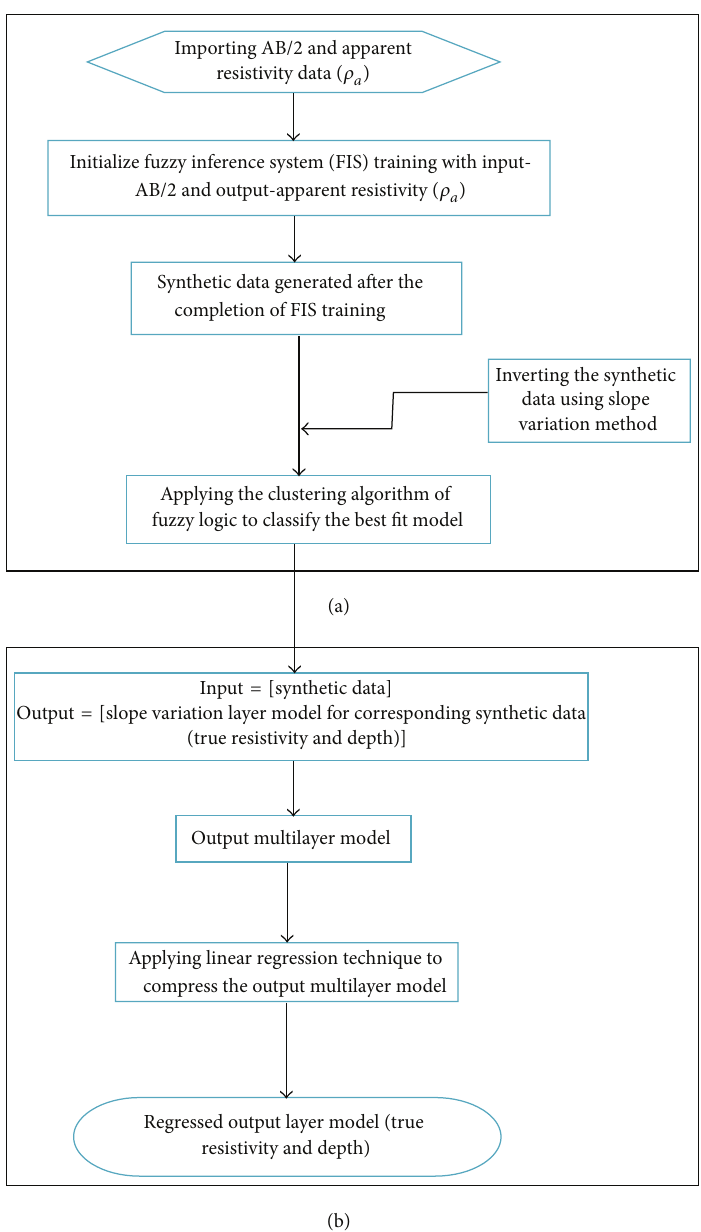
Figure 2: Flowchart showing the specially designed fuzzy clustering algorithm with (a) primary class training and (b) major class training.